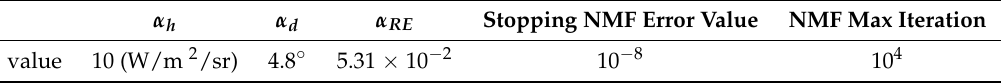
Table 5. HBEE-LCNMF parameter values for the Basel data